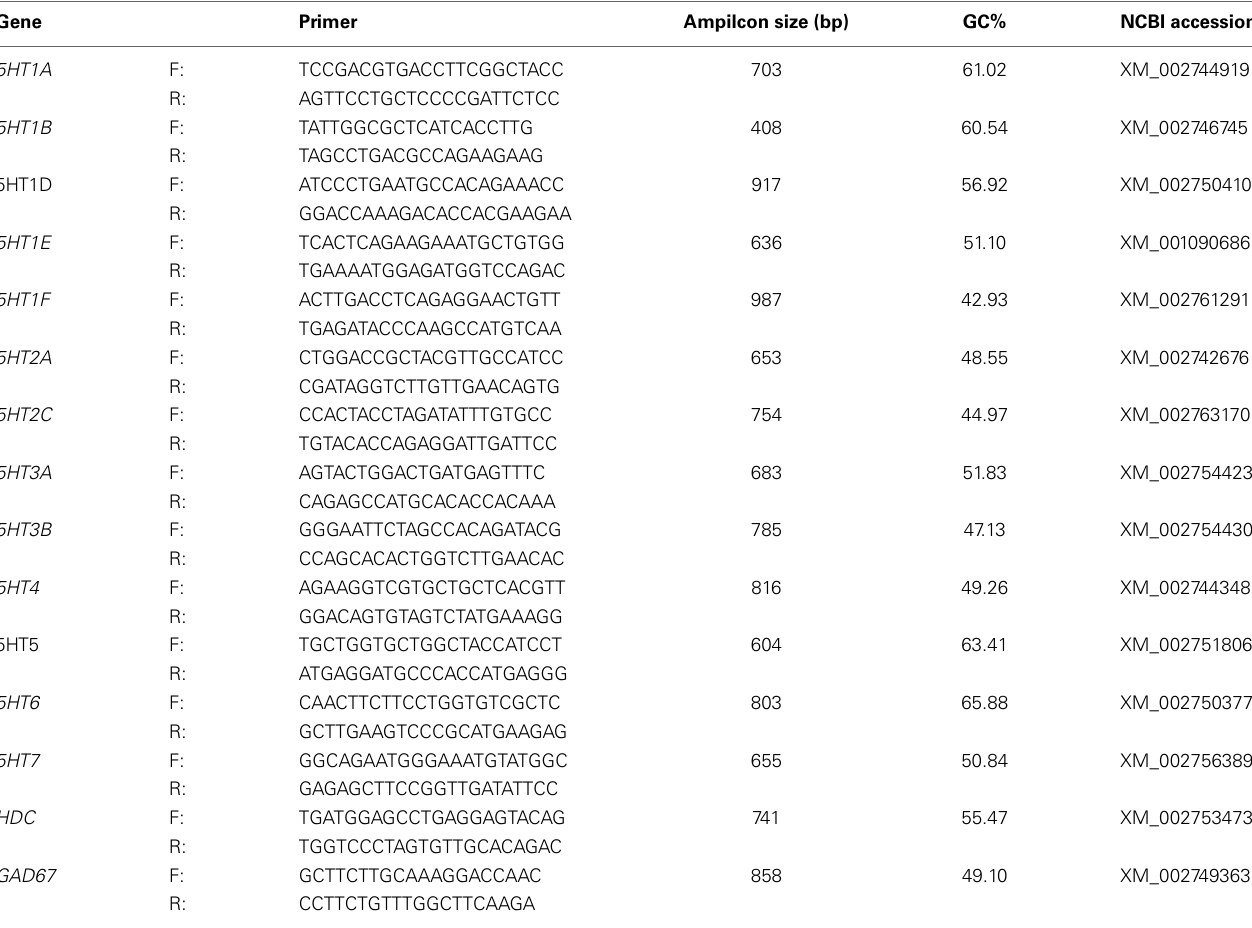
Table 1 | Summary of ISH probes for 13 serotonin receptor genes, HDC and GAD67 in the marmoset. Gene Primer Ampilcon size